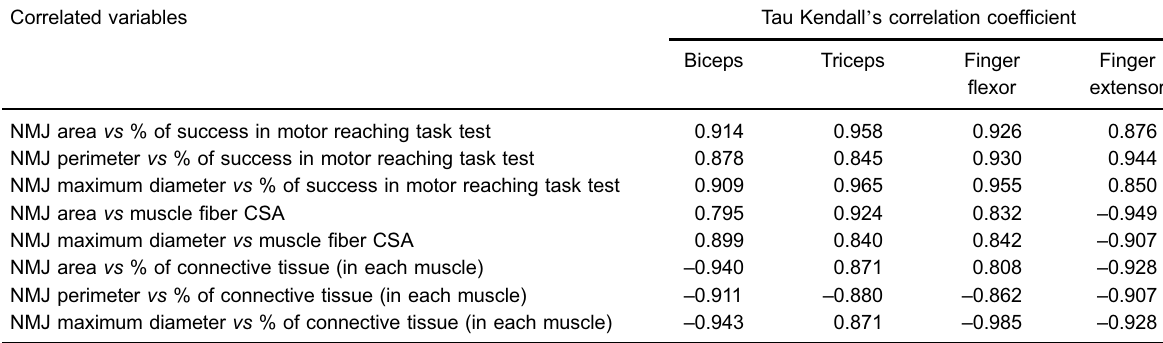
sectional area. Table 3. Correlations between morphometric characteristics of neuromuscular junction (NMJ) and motor performance in diabetes mellitus (DM) group and between morphometric characteristics of NMJ and morphometric characteristics of measured muscles (DM